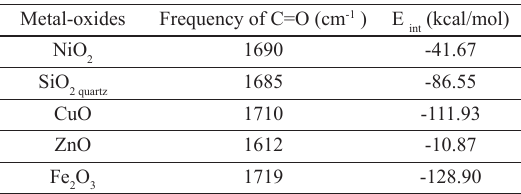
Table 2. Vibrational frequencies and interaction energies for the chosen metal oxides and PCL interfaces